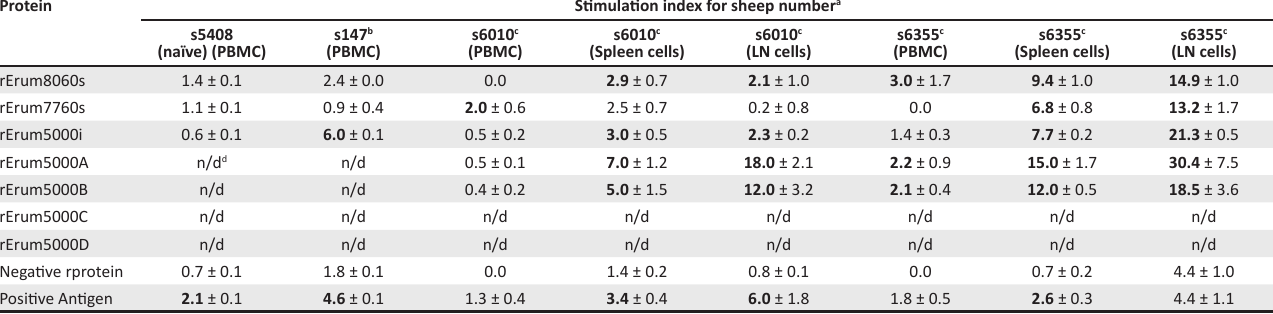
TABLE 2: Proliferative responses of peripheral blood mononuclear cells, spleen cells and lymph node cells from heartwater immune sheep stimulated with recombinant proteins. Immune cells were obtained from a naïve sheep (s5408), needle infected and challenged sheep (s147, s6010) and tick infected and challenged sheep (s6355). Protein Stimulation index for sheep number